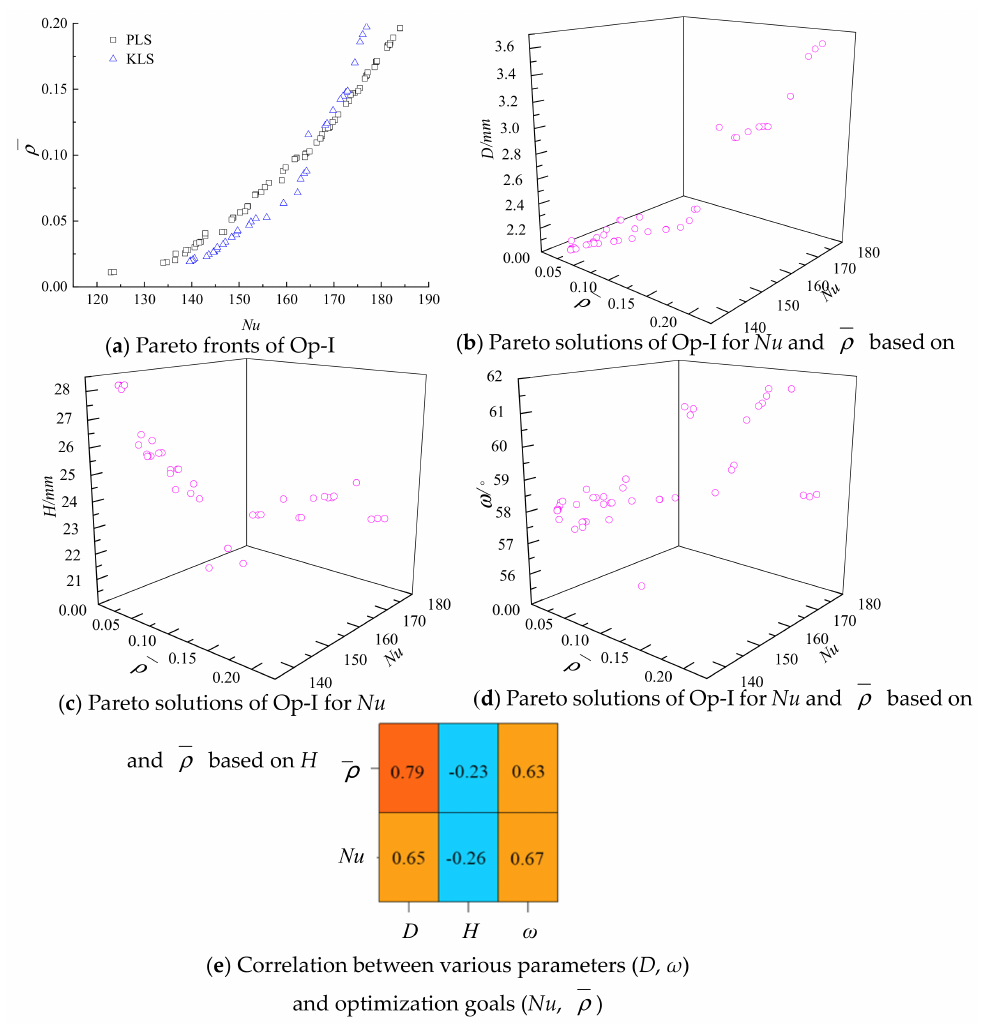
Figure 7. Sensitivity analysis for